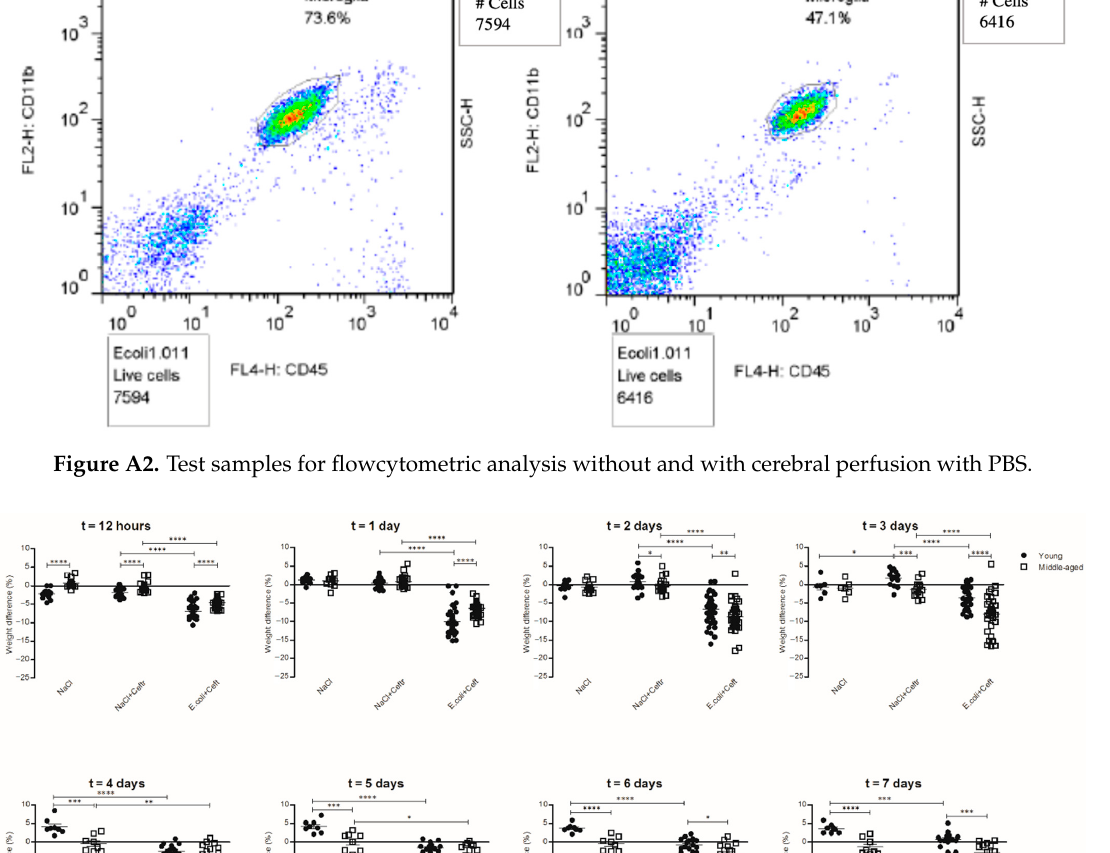
Figure A4. Bacterial outgrowth in cerebral spinal fluid (CSF), blood, spleen and liver per time point in colony-forming units per mL (CFU/mL) of all E. coli -infected mice. Note that all mice received ceftriaxone at 12 h and 1 day after inocula- tion. The red dotted line is the lower limit of detection (LLD), LLD for CSF is 2000 CFU/mL, LDD for blood is 20 CFU/mL and LDD for spleen and liver is 100 CFU/mL. Mann–Whitney U tests were performed, data represent mean ± SEM, *** p ≤ 0.001,